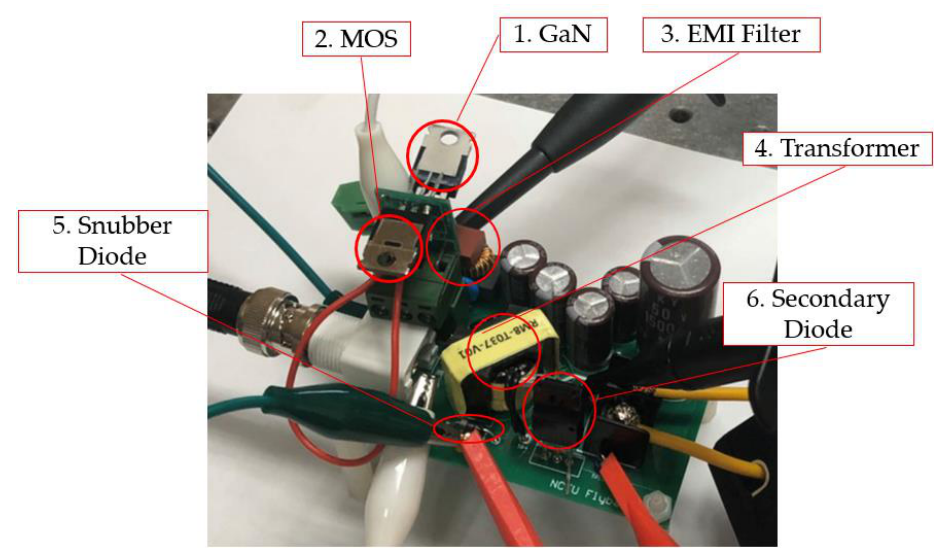
Figure 18. CCM for Vo = 20 V using Type 2A cascode.